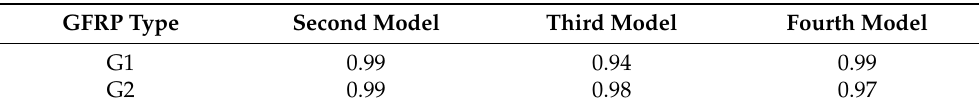
Table 19. R 2 values of the second, third, and fourth models for the estimated data and test data at 20 ◦ C.